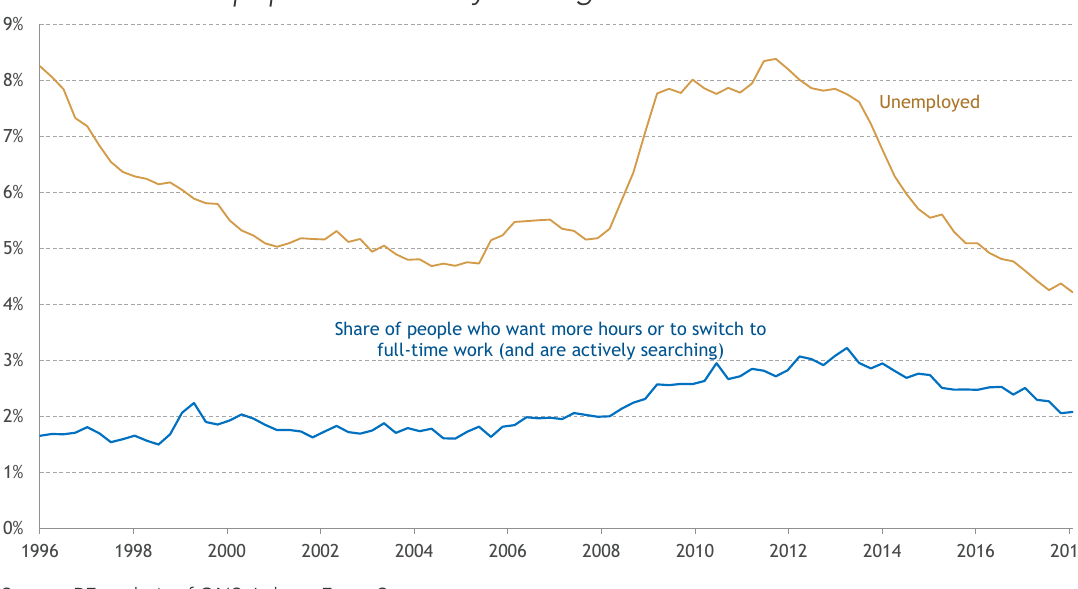
Figure 2: Unemployment and underemployment have fallen significantly over the past few years Share of the 16+ population actively looking for